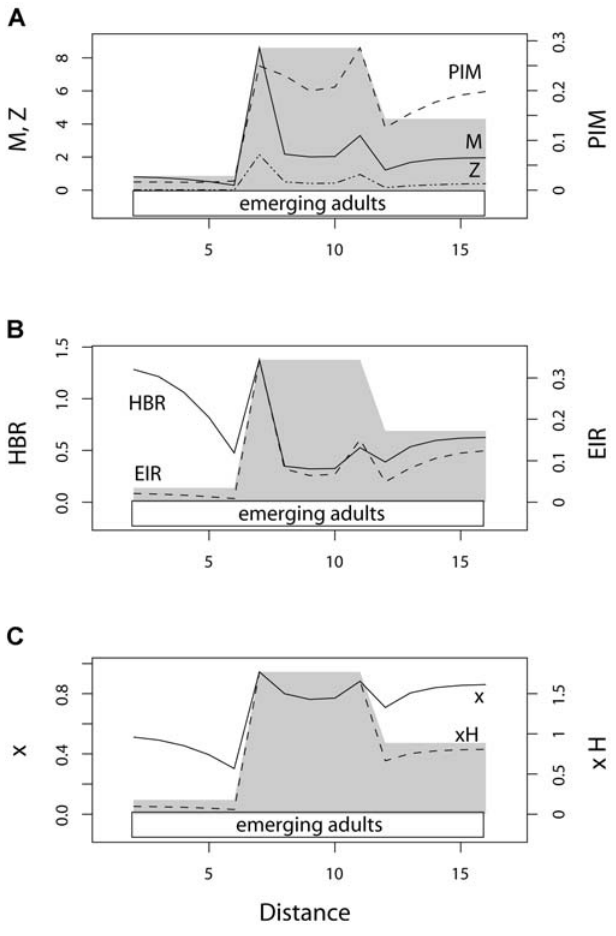
Figure 2. Statics with Homogeneous Humans and Heterogeneous Mosquitoes The components of EIR follow different trends when larval habitat is distributed at a single point and humans are uniformly distributed (the gray background illustrates the human distribution). (A) Mosquito density (solid) declines monotonically, but PIM (dashed) increases monotonically. The density of infected mosquitoes ( Z, dotted) also declines monotonically. (B) HBR (solid) and EIR (dashed) both decline monotonically away from the source, reflecting the steep gradient in mosquito density. (C) The density of infected humans (dashed) and prevalence of infection in humans (solid) also decline monotonically (the curves coincide). DOI: 10.1371/journal.pbio.0020368.g002 The human population is distributed heterogeneously in blocks of low, high, and medium density, approximating a town with a rural population on one side and an inter- mediate-density population on the other. The distribution of adult mosquitoes is influenced by the distribution of humans (Figure 3A). Aggregations of mosquitoes form spontaneously at the edges of human settlements simply because mosquitoes tend to move until they find a host. We note that the major peaks in HBR are away from town, where human population density is lowest, and at the edge of town, where human population density is highest (Figure 3B). EIR also peaks at the edge of town, but it is lowest on the low-human-density side of town. With these movement rules, the mosquitoes found on the side of town with low human density tend to be younger, hence PIM is low (Figure 3A). The prevalence of